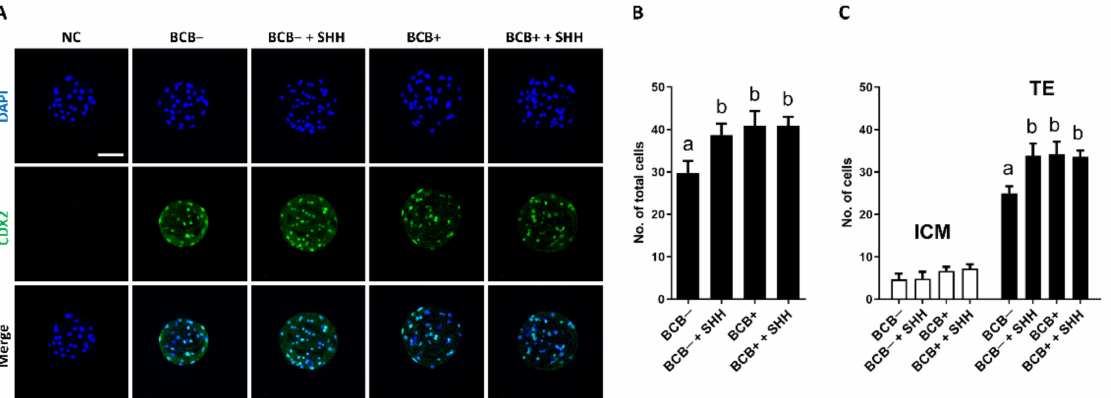
Figure 4. Effect of sonic hedgehog (SHH) protein supplementation during in vitro maturation of brilliant cresyl blue (BCB) − and BCB+ cumulus–oocyte complexes (COCs) on cell numbers of parthenogenetic blastocysts. ( A ) Representative photomicrographs of CDX2 immunocytochemical staining of parthenogenetic blastocysts developed from the indicated groups. Quantification of ( B ) the total, ( C ) inner cell mass (ICM), and trophectoderm (TE) cell numbers in the indicated groups. The experiment was independently replicated three times with at least 7 blastocysts per group. Groups indicated by different letters (a and b) represent significant differences ( p < 0.05). NC, negative control; BCB − , BCB non-stained COCs; BCB − + SHH, BCB − COCs supplemented with 0.5 µ g/mL SHH protein; BCB+, BCB stained COCs; BCB+ + SHH, BCB+ COCs supplemented with 0.5 µ g/mL SHH protein. Bar = 100 µ m.